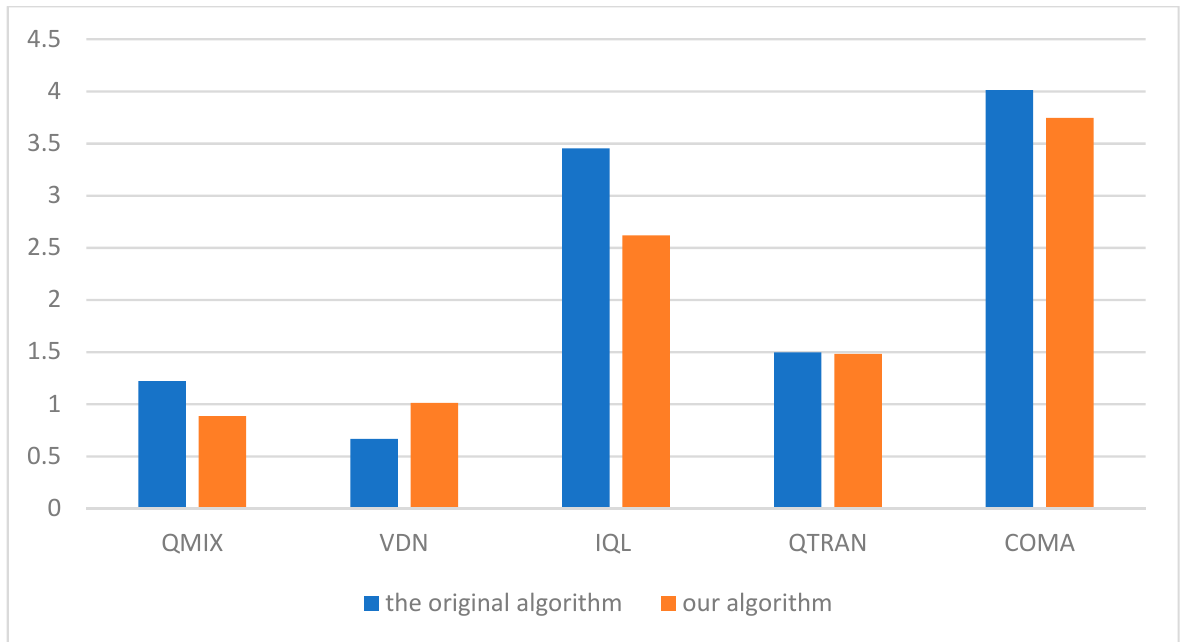
Figure 3. Standard deviation of test return.